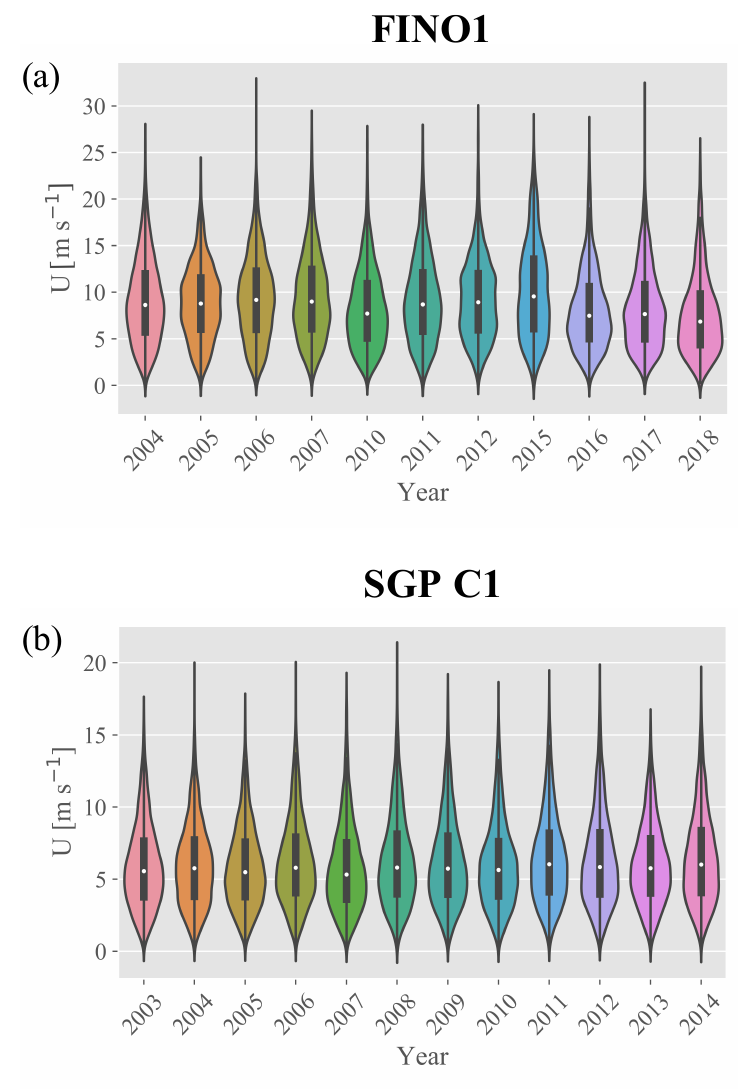
Figure 1. Violin plot of annual wind speed distribution for all training and testing data at the ( a ) FINO1 and ( b ) Southern Great Plains (SGP) C1 sites. Years without any data availability are removed for